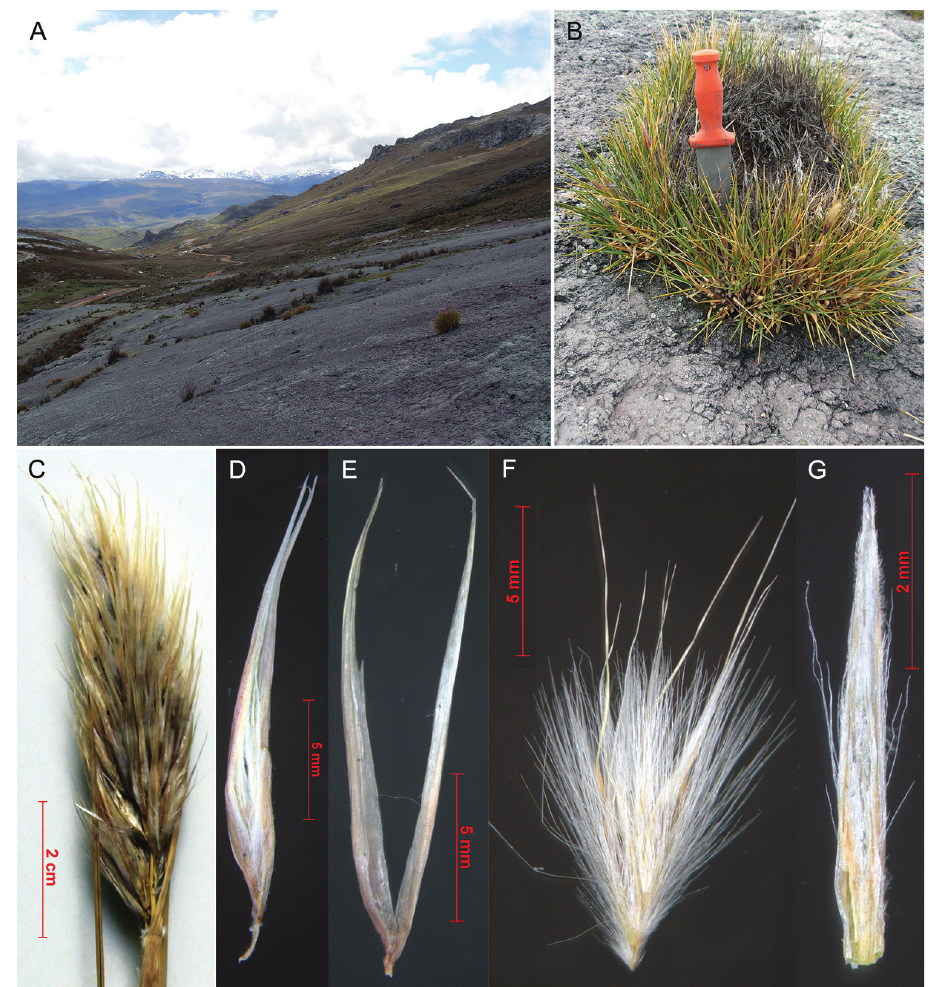
Figure 4. Cortaderia echinata (all from Peterson 21587). A habitat on bare rock slabs B habit, forming a vegetable hedgehog C inflorescence D spikelet, somewhat squashed (all very compact in the inflores- cence) E glumes F floret package, with three florets, note long lemma indumentum G palea with sparse indumentum on the lateral palea flaps. A and B were photographed by Paul Peterson and Robert